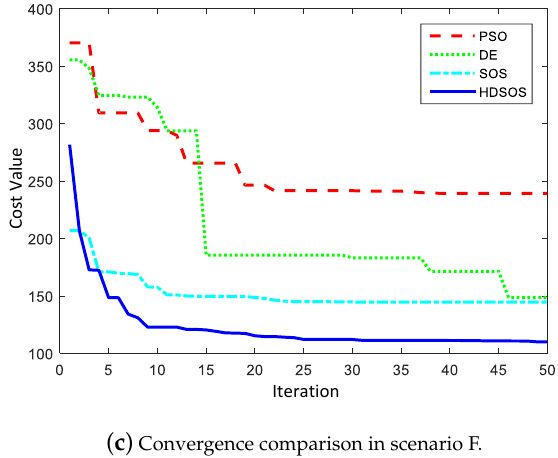
Figure 11. The comparative results for three-dimensional scenario